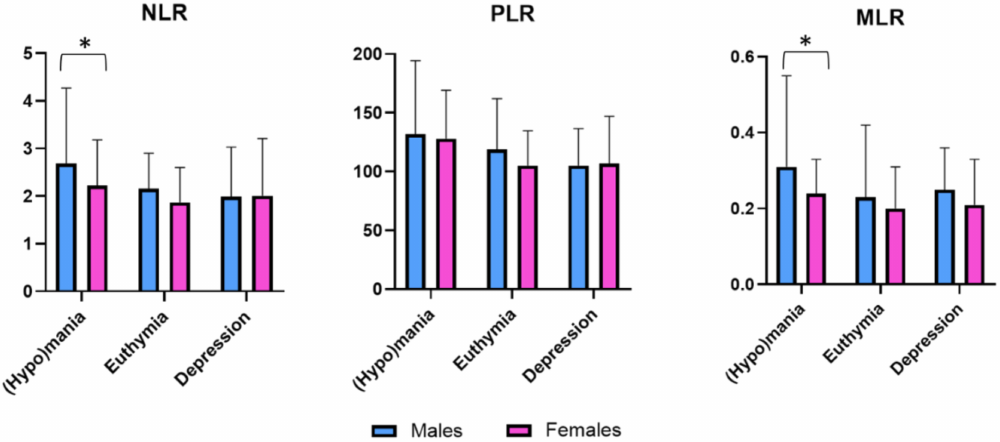
Figure 1. Gender differences in neutrophil-to-lymphocyte (NLR), platelet-to-lymphocyte (PLR), and monocyte-to- lymphocyte (MLR) ratios according to bipolar state. * Statistically significant difference ( p <